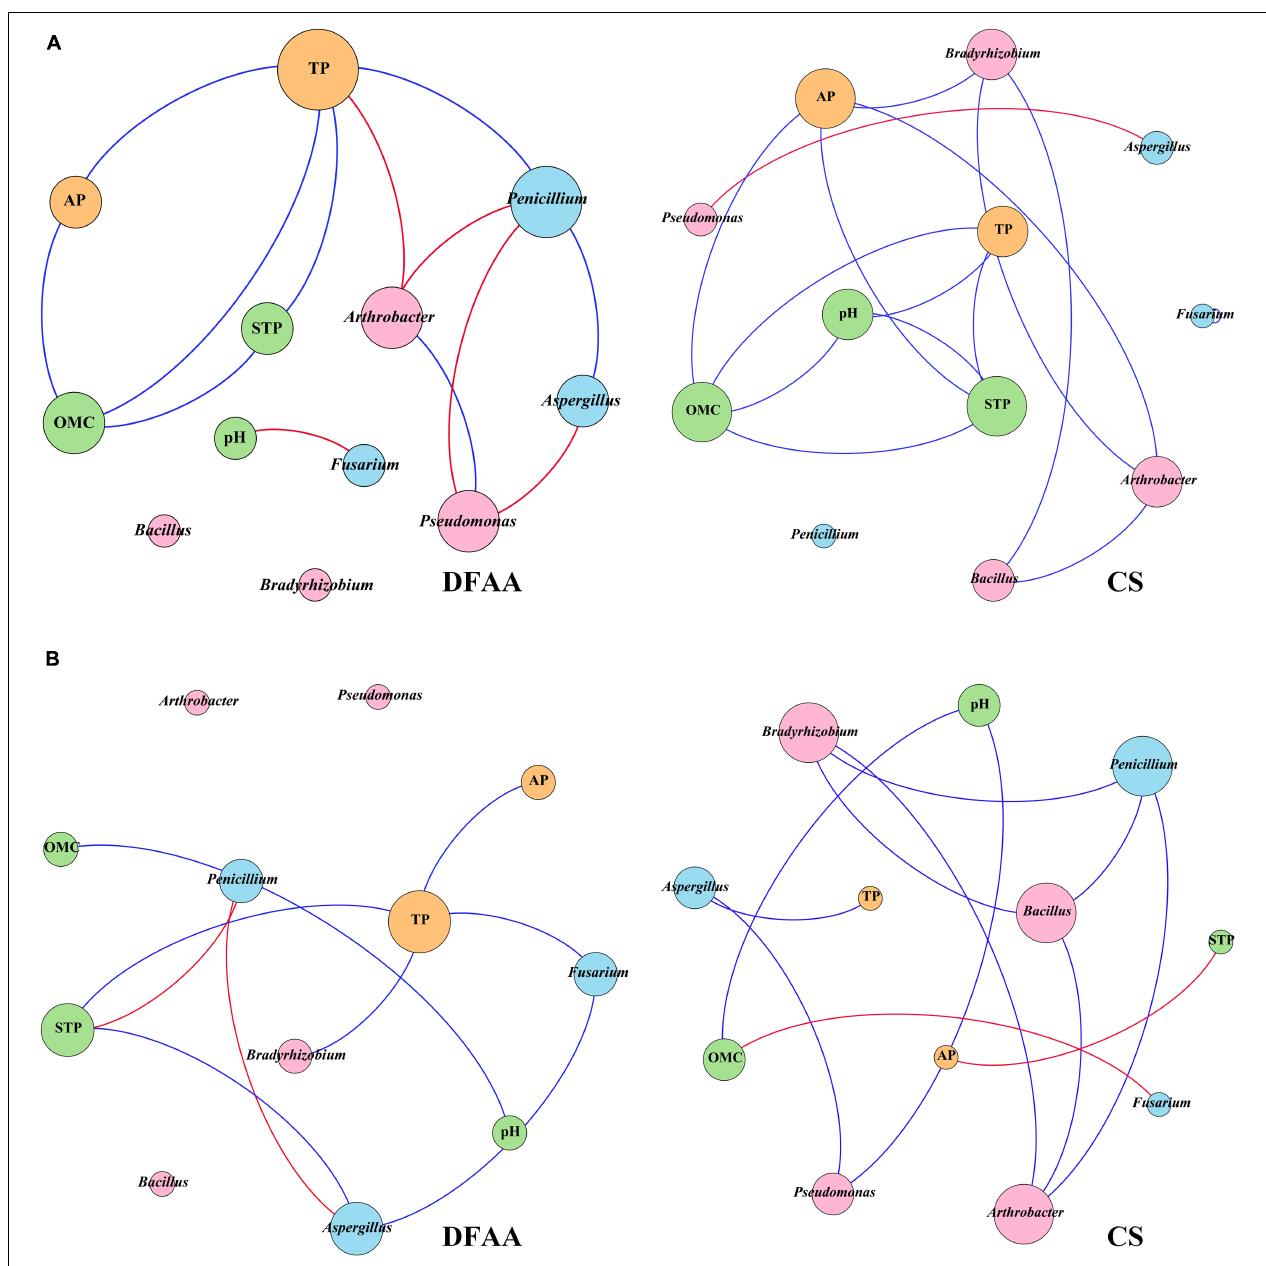
FIGURE 7 | The co-occurrence networks between phosphate-solubilizing microorganisms and soil physicochemical properties related to phosphorus metabolism (A) after DFAA/natural rainfall (APre); (B) at the mature period (M). Blue lines represent positive correlations, red lines represent negative correlations (Spearman’s | ρ | > 0.6, P < 0.05). Orange nodes represent the phosphorus in different forms, pink nodes represent the phosphate-solubilizing bacteria, light blue nodes represent the phosphate-solubilizing fungi, green nodes represent the soil physicochemical parameters related to phosphorus metabolism.